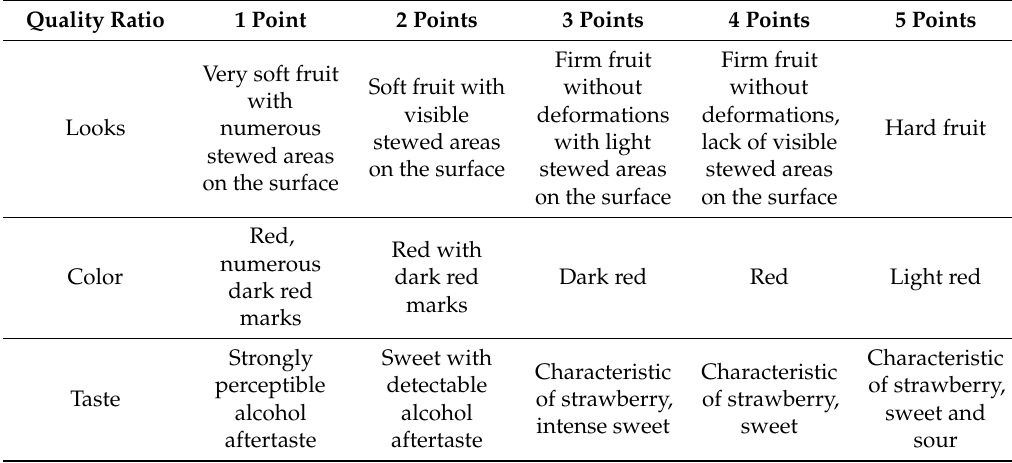
Table 1. Criterion for strawberry evaluation conducted by